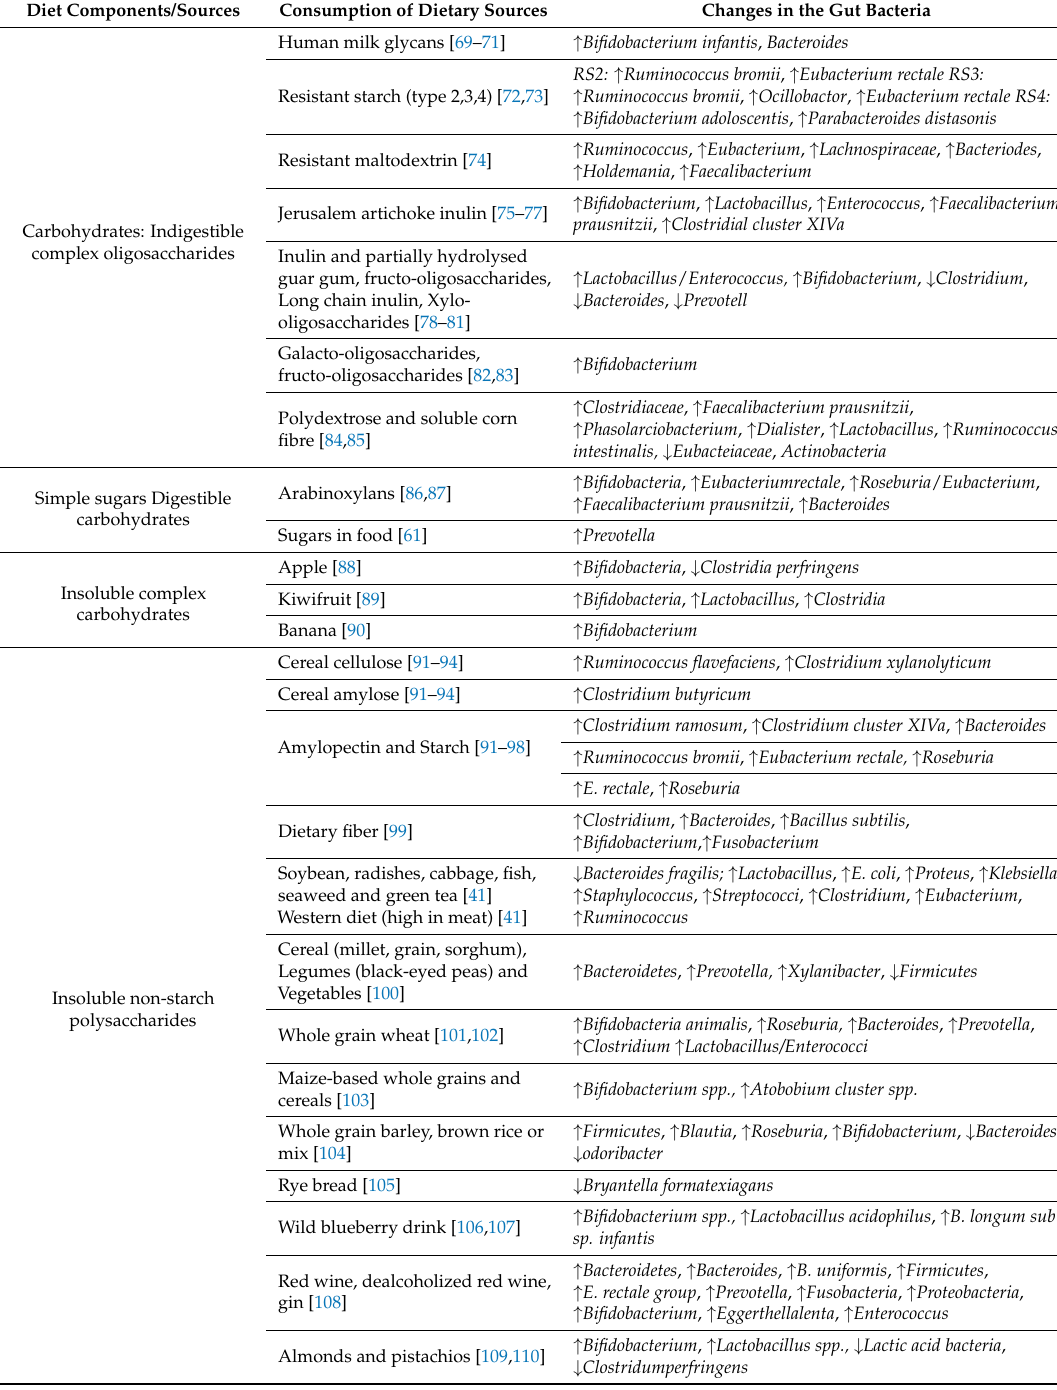
Table 1. Association between the diet and the gut